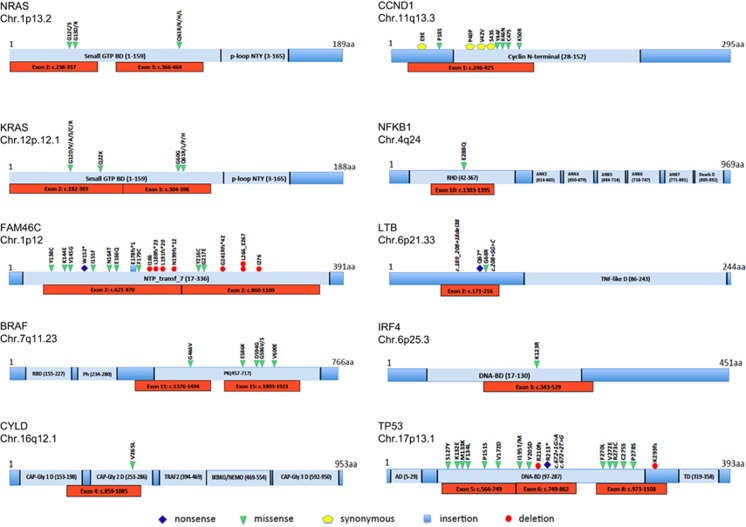
Panel of genes and hot spot regions covered by the next-generation sequencing panel including previously identified alterations. Alteration type and location of mutations in NRAS, KRAS, FAM46C, CCND1, IRF4, BRAF, CYLD, TP53, NFKB1 and LTB genes previously identified in multiple myeloma are shown. Red bars indicate regions chosen for hot spot sequencing. AD, transactivation domain; ANK, ankyrin domain; BD, binding domain; CAP-Gly, cytoskeleton-associated protein glycine-rich; DAG, diacilglycerol; NTP_transf_7, nucleotidyltransferase; p-loop NTY, containing nucleoside triphosphate hydrolase; Ph, phorbol-ester/DAG-type; RBD, ras binding domain; PK, protein kinase; RHD, real like domain; TD, tetramerization domain; TNF, tumor necrosis factor domain.